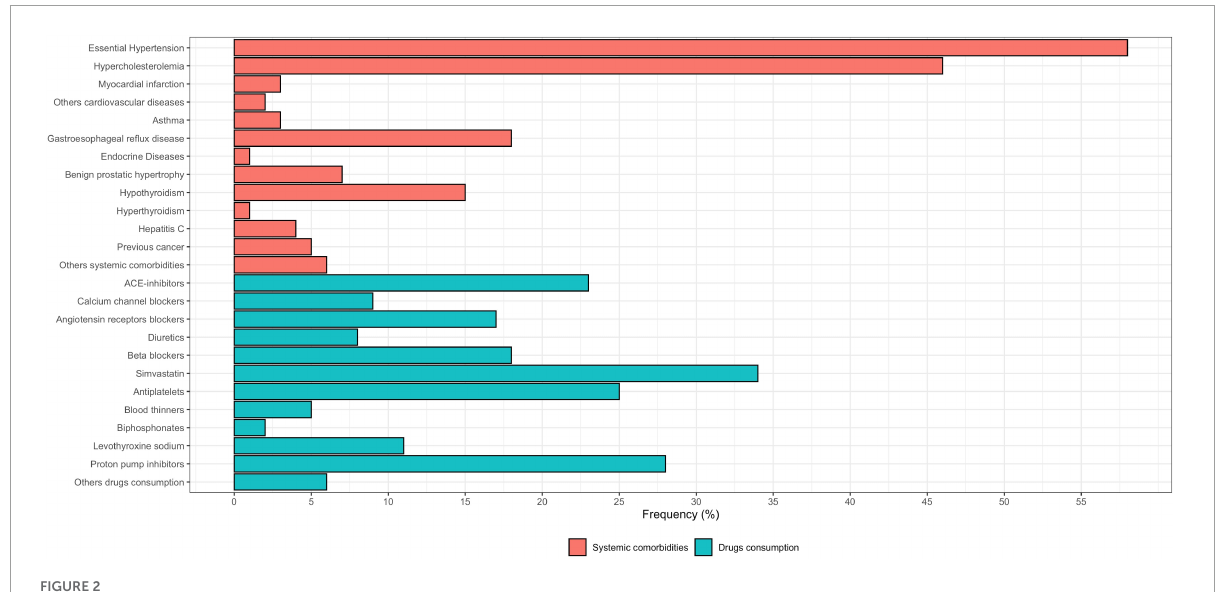
FIGURE2 Boxplot of systemic comorbidity and drug intake in BMS patients.